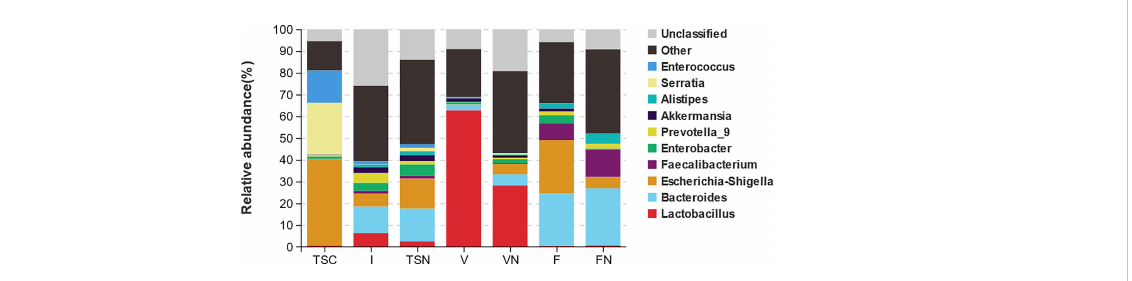
FIGURE 3 Taxa distribution plots at phylum and genus level. The relative abundances of microbial communities at genus level. TSC, Transitional stools of caesarean delivered neonates; I, Transitional stools of caesarean delivered neonates with the treatment of swabbing maternal vaginal fl uid intervention; TSN, Transitional stools of natural delivered neonates; VN, Vaginal fl uids of the pregnant women who underwent natural delivery; V, Vaginal fl uids of the pregnant women who underwent caesarean delivery; FN, Feces of the women who underwent natural delivery; F, Feces of the pregnant women who underwent caesarean delivery.